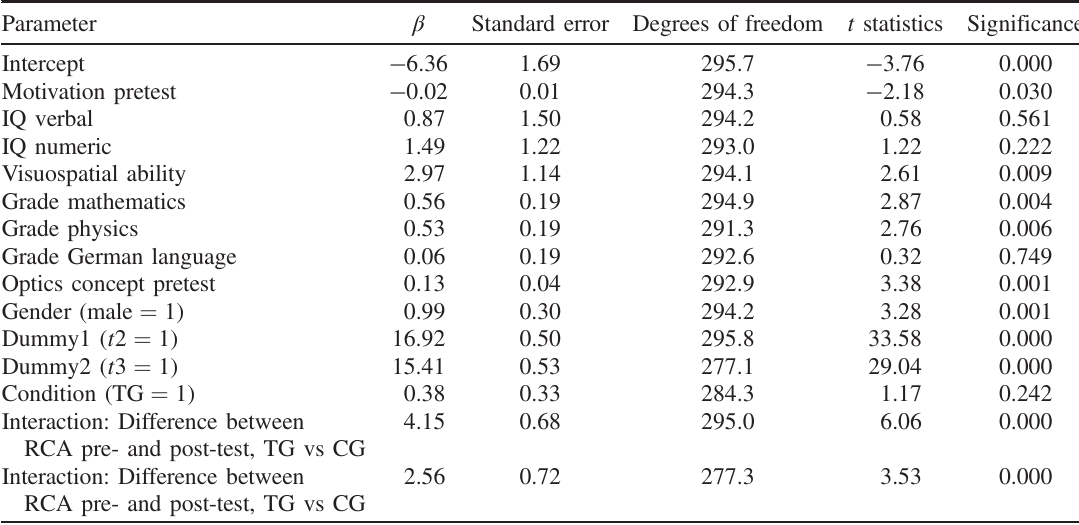
TABLE VIII. Results of the multilevel analysis for S and DU assessment items together: influence of variables on the changes of students ’ RCA between pre- and post-test, pre- and follow-up test, and the groups, fixed effects (multilevel model for measuring